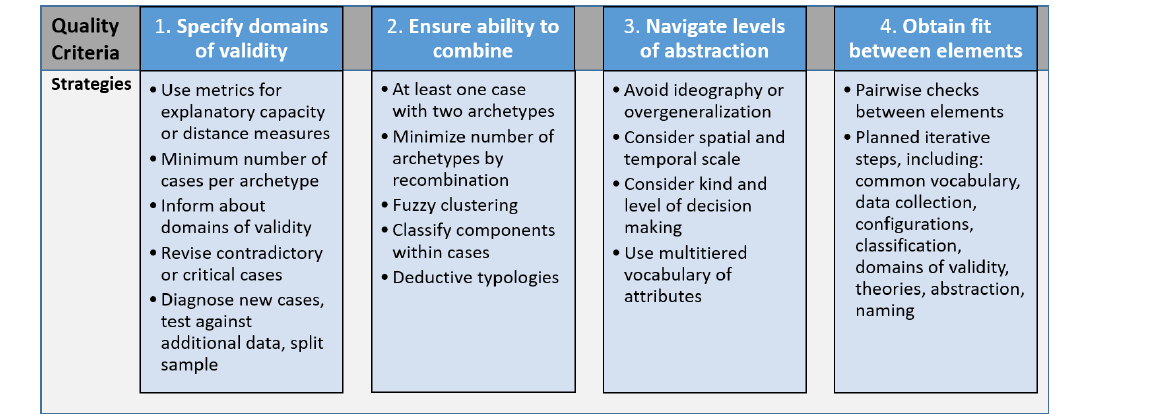
Fig. 2 . Recommended design and quality criteria for archetype analysis. Numbers correspond to the following subsections with more details. The four columns propose possible strategies that may be chosen in a research design to approach the quality criteria (see explanations in the